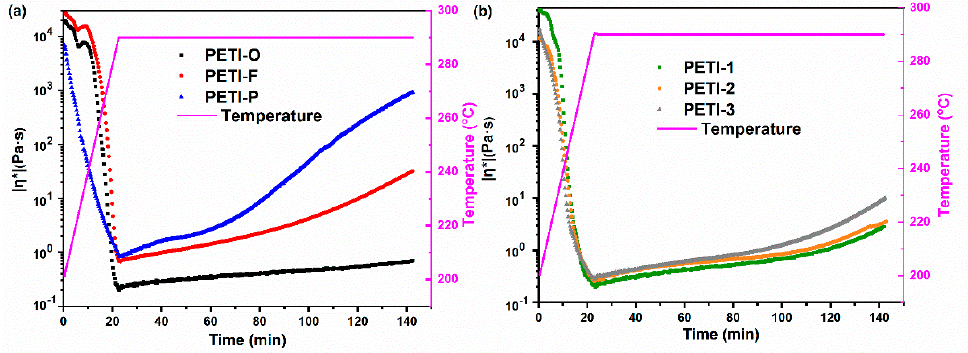
Figure 6. The variation of complex viscosities of ( a ) PETI-O, PETI-F, PETI-P and ( b ) PETI-1, PETI-2, PETI-3 at 280 °C.